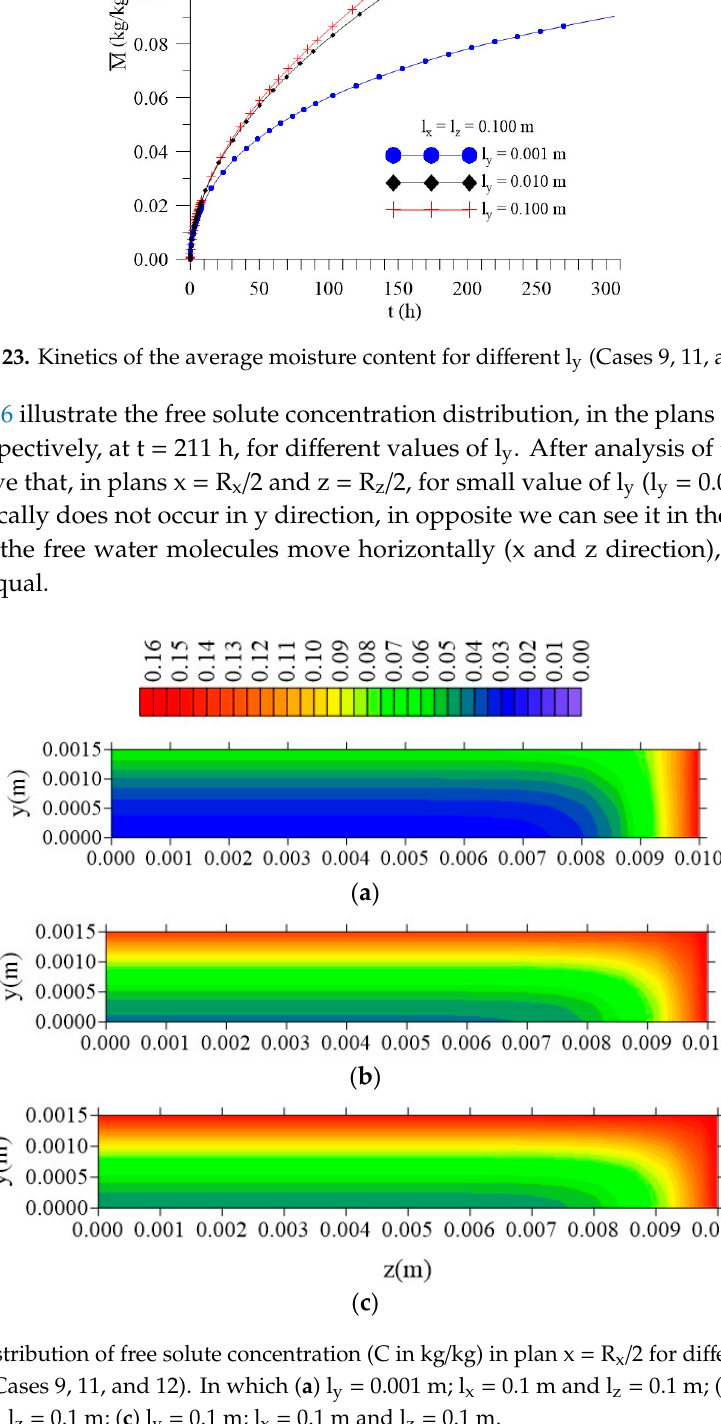
Figure 23. Kinetics of the average moisture content for different l y (Cases 9, 11, and 12).